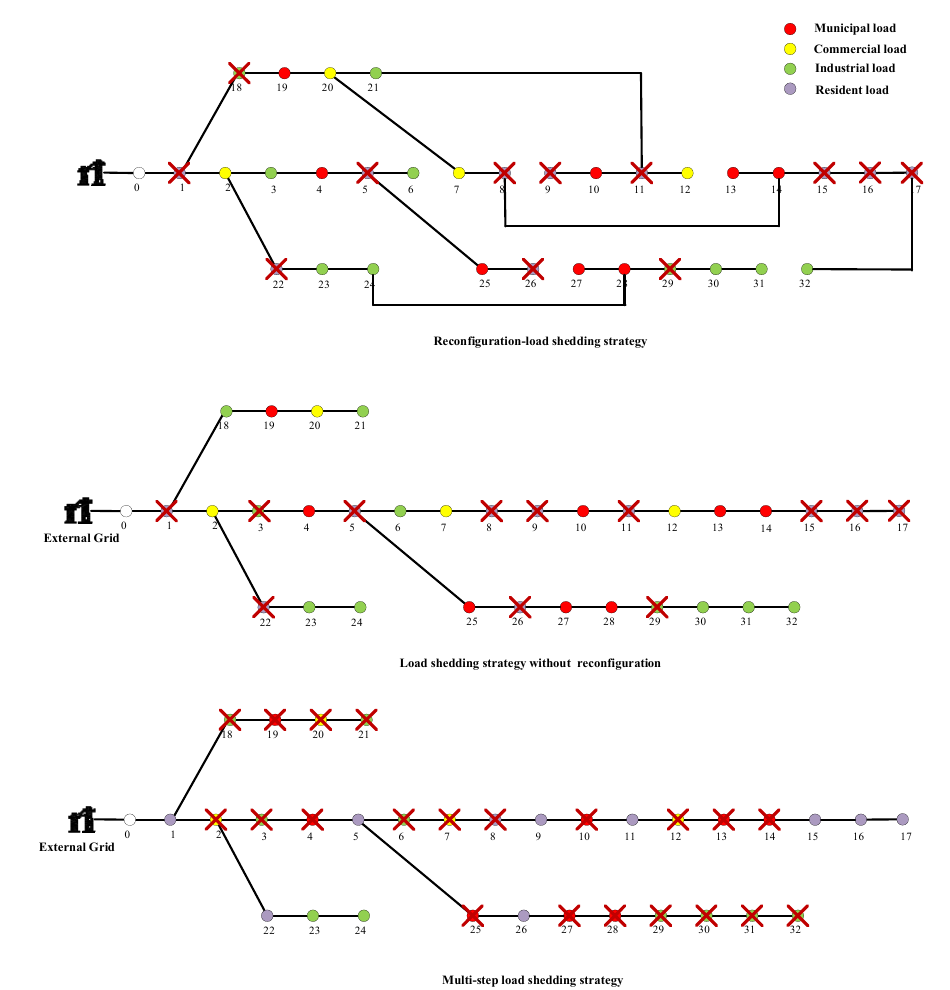
Figure 11. Removed loads distribution with the lowest economic loss as the main objective.